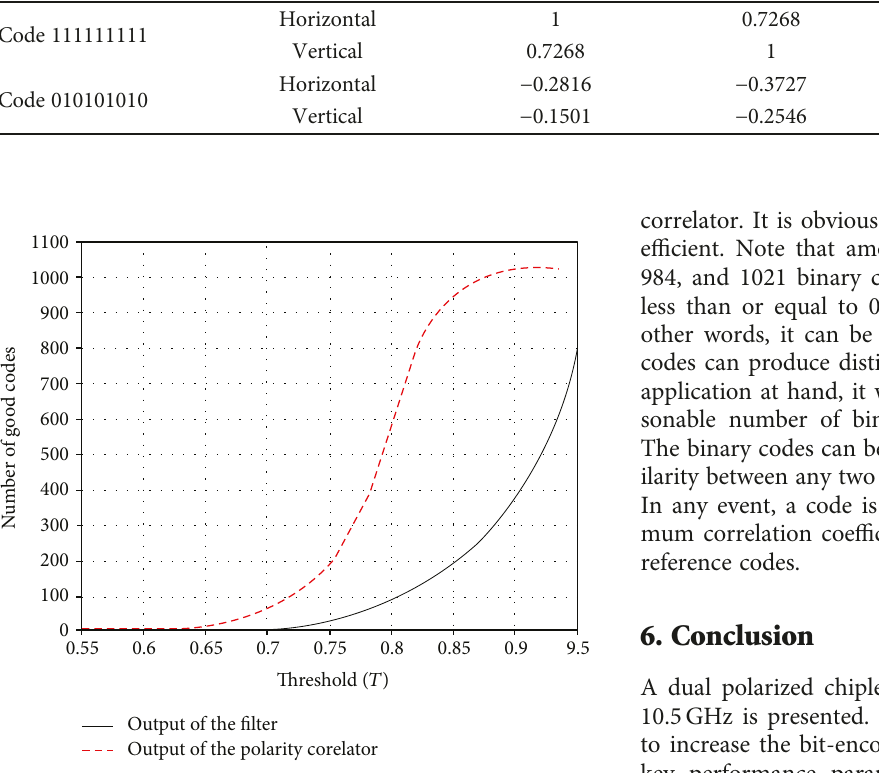
Figure 9: The binary codes whose correlation coe ffi cient is less than the threshold T for the output of the fi lter and the polarity